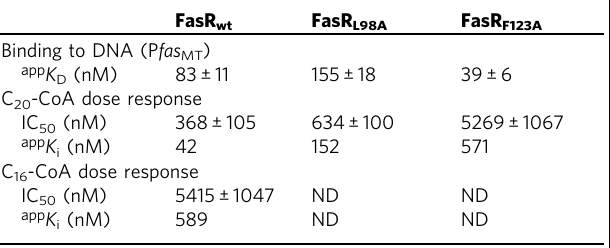
Comparison of FasR wt vs mutants FasR L98A and FasR F123A that uncouple the allosteric effect. app K D and IC 50 values are reported as the average of at least three independent experiments± one standard error of the mean. ND: not